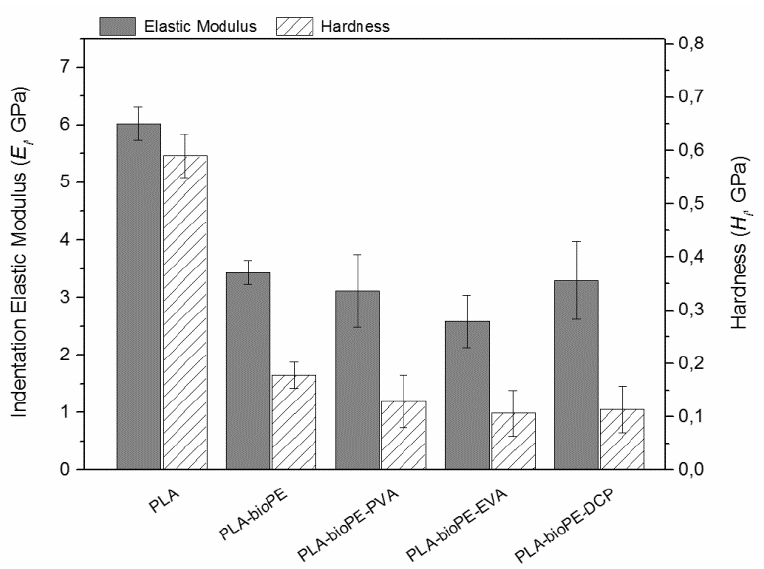
Figure 7. Nanoindentation E and H results of neat PLA, PLA-bioPE, and PLA-bioPE blend compatibilized with PVA, EVA, and